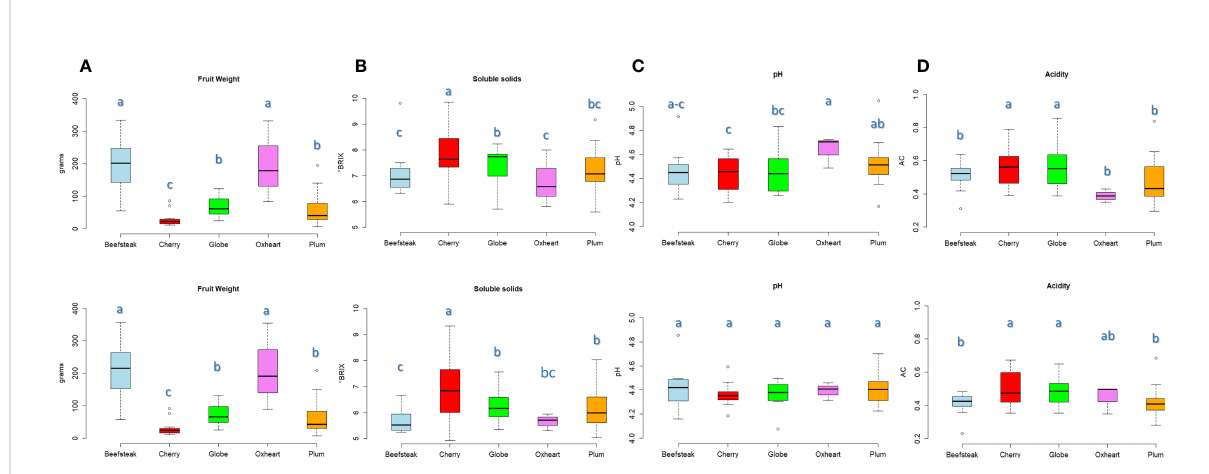
FIGURE 1 Variation for fruit weight and chemical traits in the fi ve heirloom groups across two seasons. Boxplots showing the average value and quartiles ( fi rst and third) for traits scored in the fi rst (above) and the second (below) seasons, respectively. The measurement scale for each trait is reported on the Y -axis. Means with different letters are signi fi cantly different ( P = 0.05) according to Tukey ’